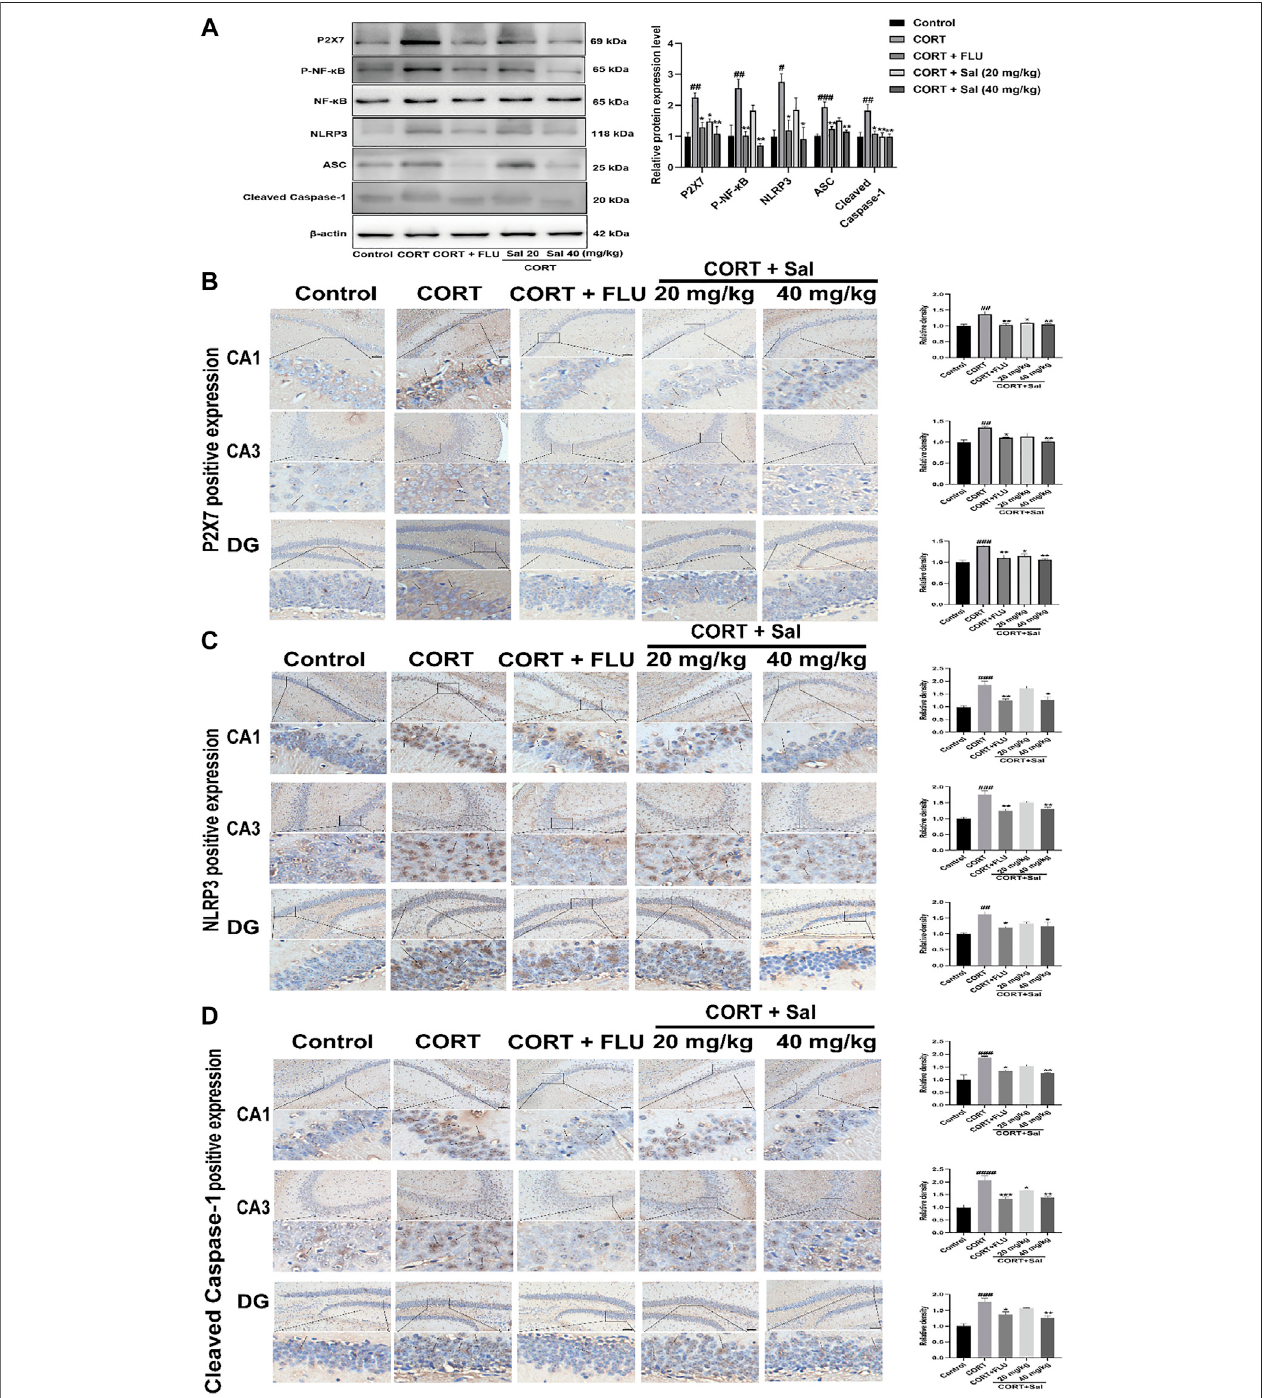
FIGURE 3 | Sal suppresses P2X7/NF- κ B/NLRP3 signaling pathway in CORT-induced mice. (A) The expression of P2X7, P-NF- κ B, and NLRP3 in fl ammasome- associated proteins in the hippocampus was checked by Western blot ( n = 3). (B) The typical expression of P2X7 in the hippocampus was detected by immunohistochemical staining. (C) Sal reduced NLRP3 protein concentrationsin thehippocampus wasexamined byimmunohistochemical staining. (D) Sal decreased Cleavedcaspase-1expressioninhippocampusCA1,CA3,andDG,measuredbyIHCassay.ThetypicalpositivestainingofP2X7,NLRP3,andCleavedcaspase-1 wererepresented bybrownstaining(black arrows). Originalmagni fi cation: ×200, n =3. #### p < 0.0001, ### p < 0.001, ## p < 0.01compared withthecontrolgroup; ** p < 0.01, * p < 0.05 compared with the CORT